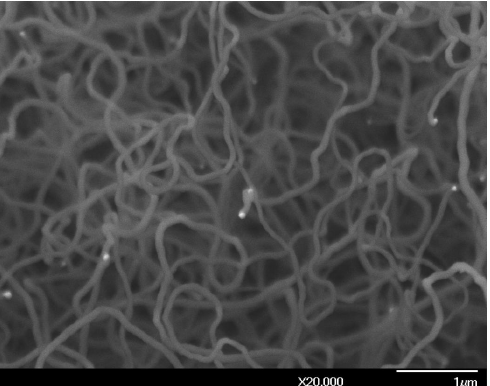
Figure 2. Microscopic images of multi-walled carbon